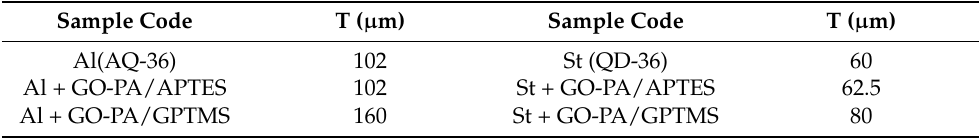
Table 3. Thickness values of the uncoated and coated samples obtained from the chromatic maps.